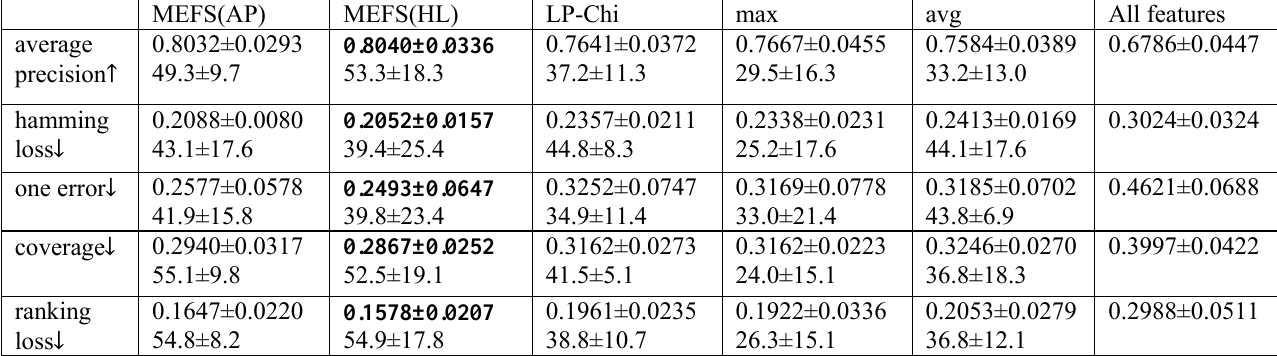
Table 4. Comparative results with Rank-SVM